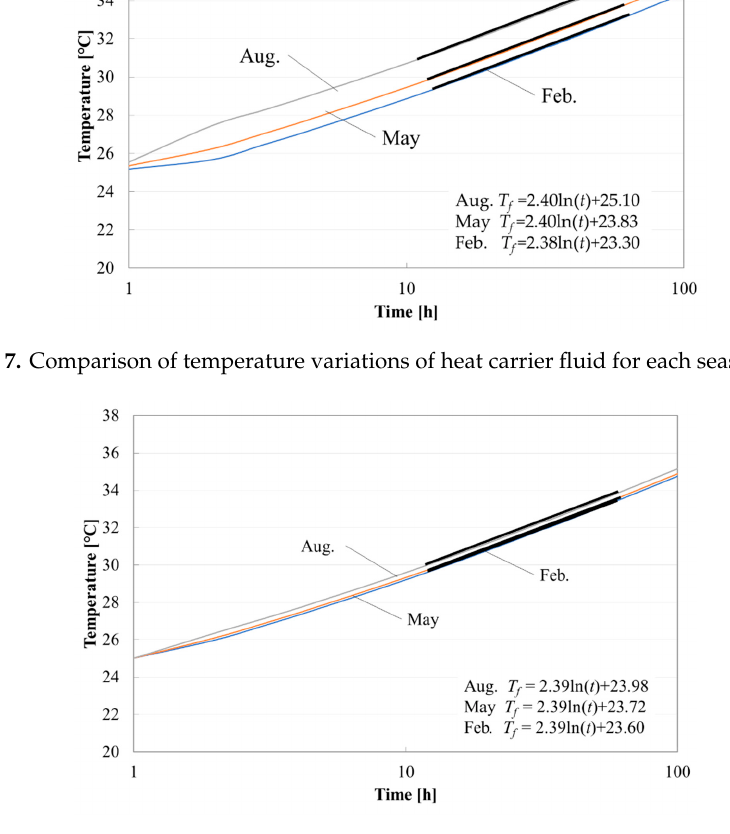
Figure 8. Comparison of temperature variations of heat carrier fluid for each season (100 m).